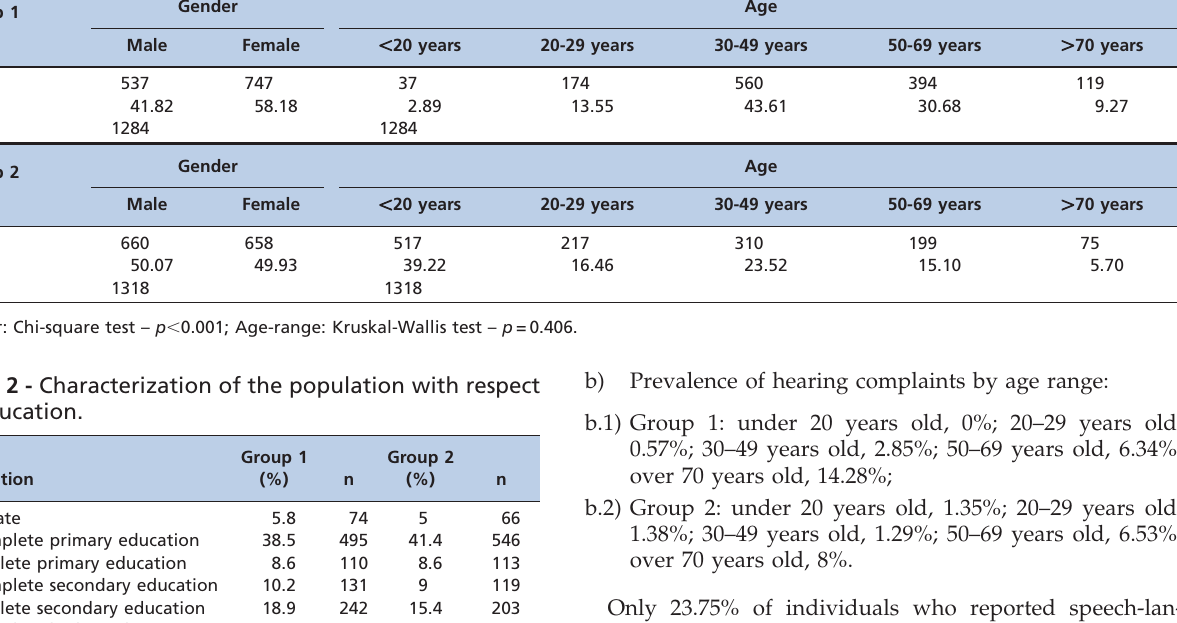
Table 1 - Characterization of the population by gender and age (n= 2602). Group 1